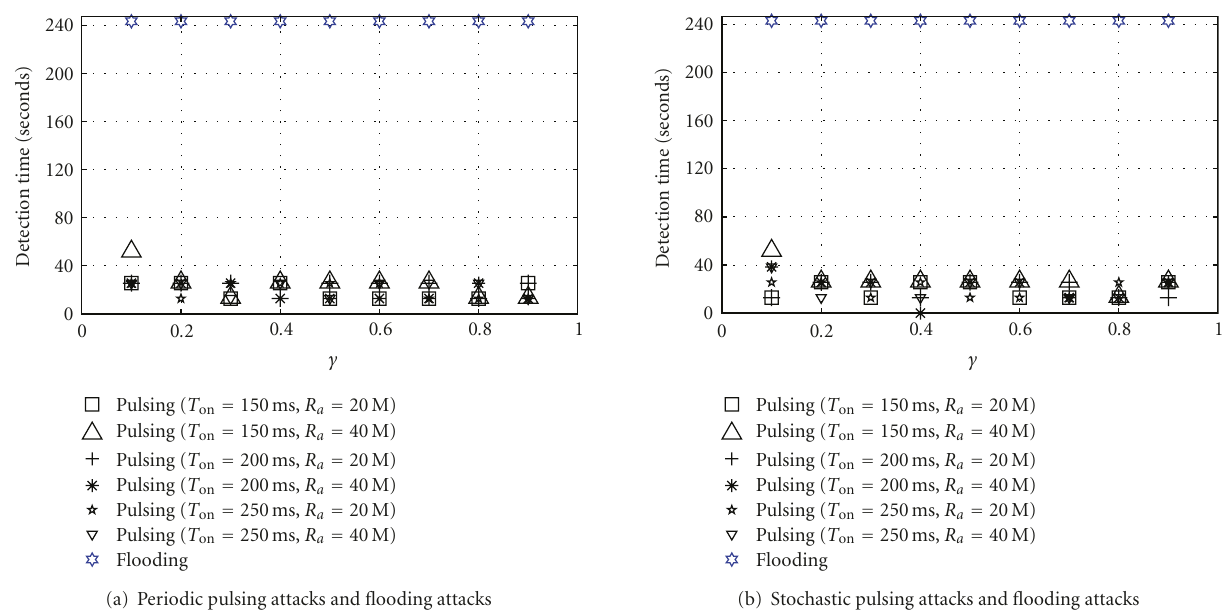
Figure 8: Average detection time for pulsing and flooding attacks using the WCM method.